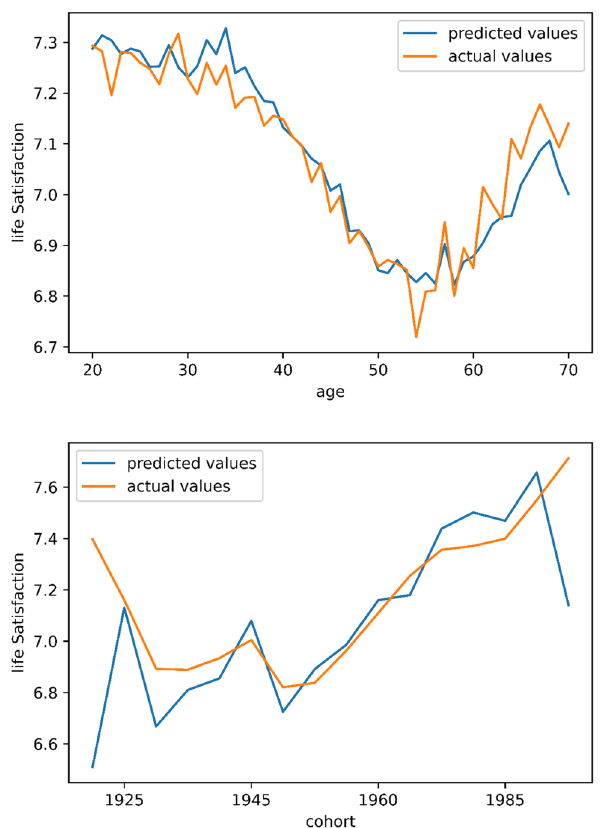
Figure 1. Predictions of life satisfaction on test data. Neural network predictions of life satisfaction as a function of age and cohorts. The blue line indicates the predicted values given the test data, while the orange line shows the actual values within the test